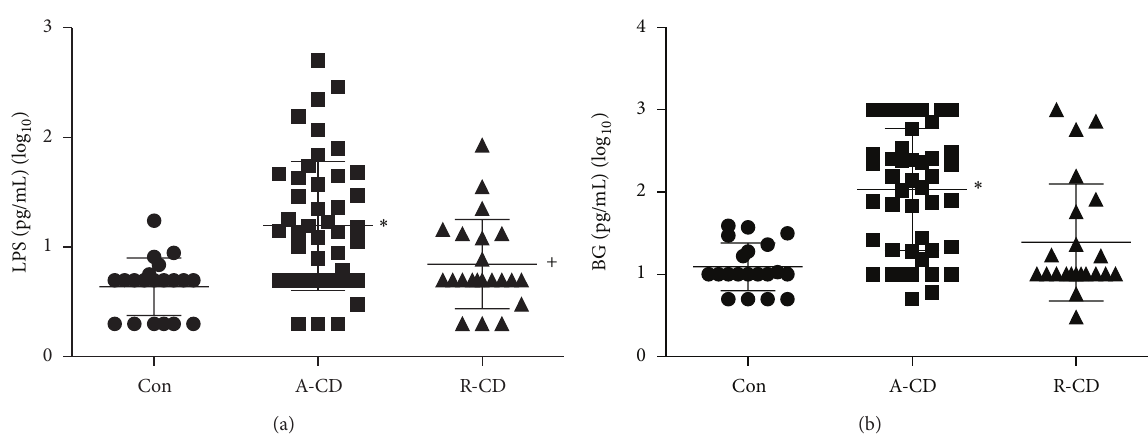
Figure 1: Serum levels of LPS and BG (log 10 formation) in A-CD patients. (a) Levels of LPS were significantly increased in patients with A-CD as compared with R-CD and healthy controls (Con) ( + 𝑃 < 0.05 , A-CD VS R-CD; ∗ 𝑃 < 0.01 , A-CD VS Con); (b) Serum levels of BG were markedly increased in patients with A-CD as compared with R-CD and Con ( ∗ 𝑃 < 0.01 , A-CD VS R-CD or Con).